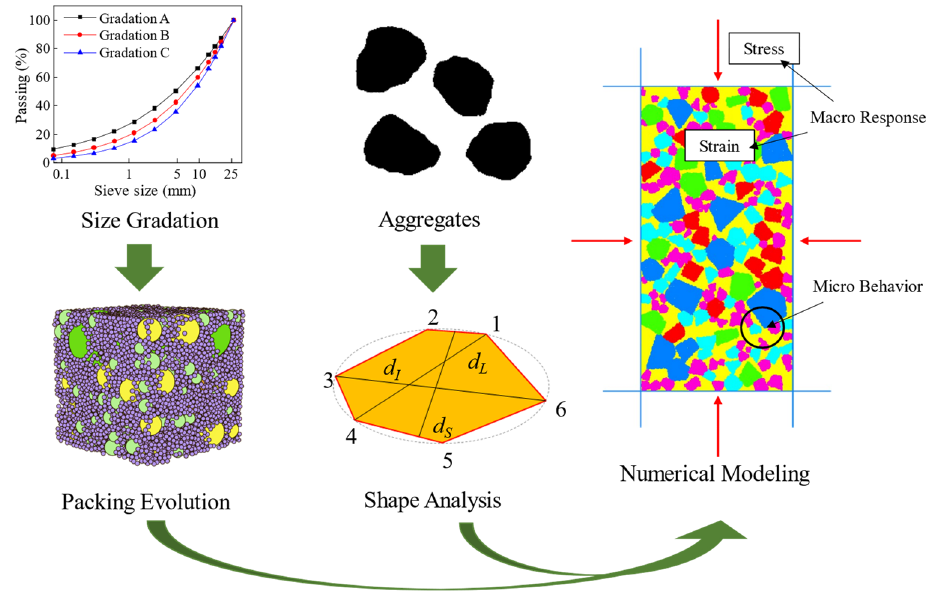
Figure 9. Digital aggregate modeling approach based on aggregate properties.